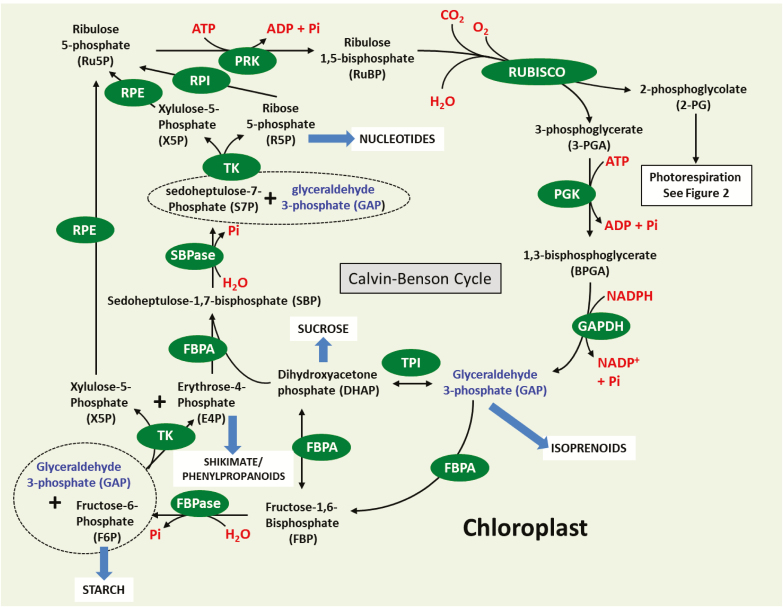
Schematic representation of the Calvin–Benson cycle. Sedoheptulose-1,7-bisphosphatase (SBPase: EC 3.1.3.37), fructose-1,6-bisphosphate aldolase (FBPA: EC 4.1.2.13), fructose-1,6-bisphosphatases (FBPase; EC 3.1.3.11), transketolase (TK; EC 2.2.1.1), phosphoribulokinase (PRK; EC 2.7.1.19), ribulose-phosphate 3-epimerase (RPE; EC 5.1.3.1), triosephosphate isomerase (TPI; EC 5.3.1.1), glyceraldehyde 3-phosphate dehydrogenase (GAPDH; EC 1.2.1.12), phosphoglycerate kinase (PGK; EC 2.7.2.3), ribose 5-phosphate isomerase A (RPI; EC.5.3.1.6), Rubisco (EC 4.1.1.39).